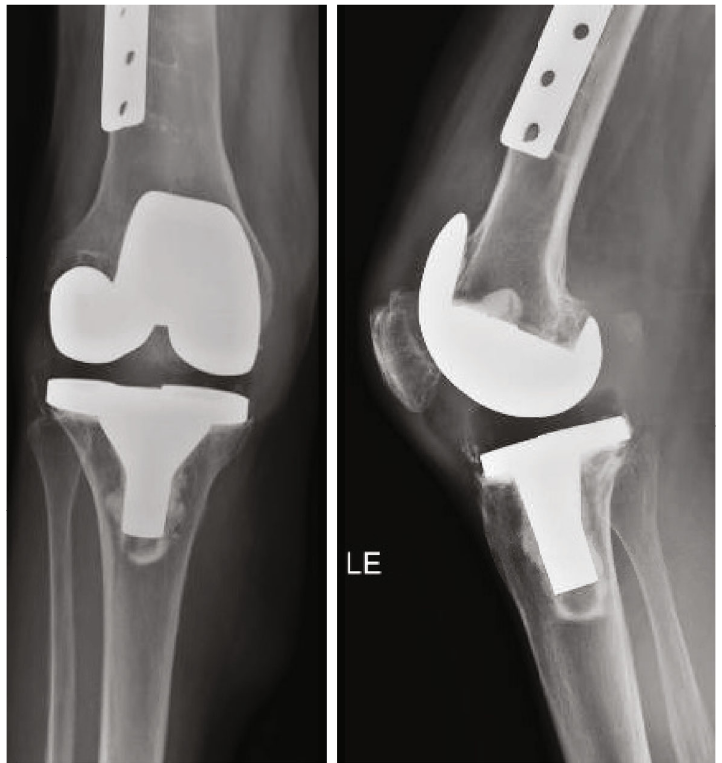
Figure 3: Preoperative total knee prosthesis.